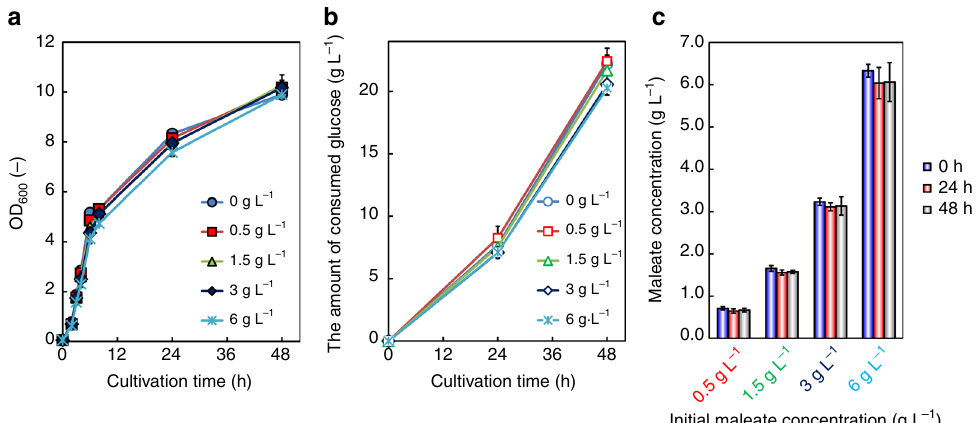
Fig. 4 Culture pro fi les of CFT5 cultured in M9Y medium supplemented with different concentrations of maleate. Time courses of a bacterial cell growth and b the total amount of consumed glucose. The amounts of supplemented maleate were 0, 0.5, 1.5, 3 and 6 g L − 1 . c Changes in the maleate concentration during cultivation. Data are presented as the mean ± standard deviation of three independent experiments ( n = 3)